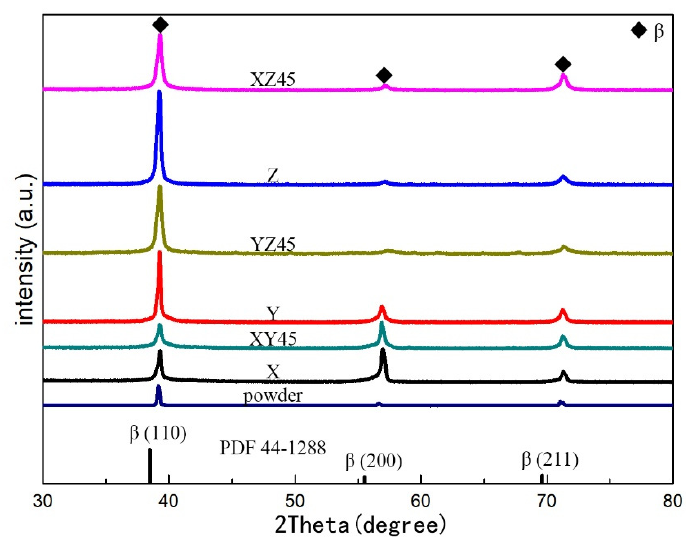
Figure 5. The XRD spectra of pre-alloy powder and as-fabricated samples of Ti-55511.